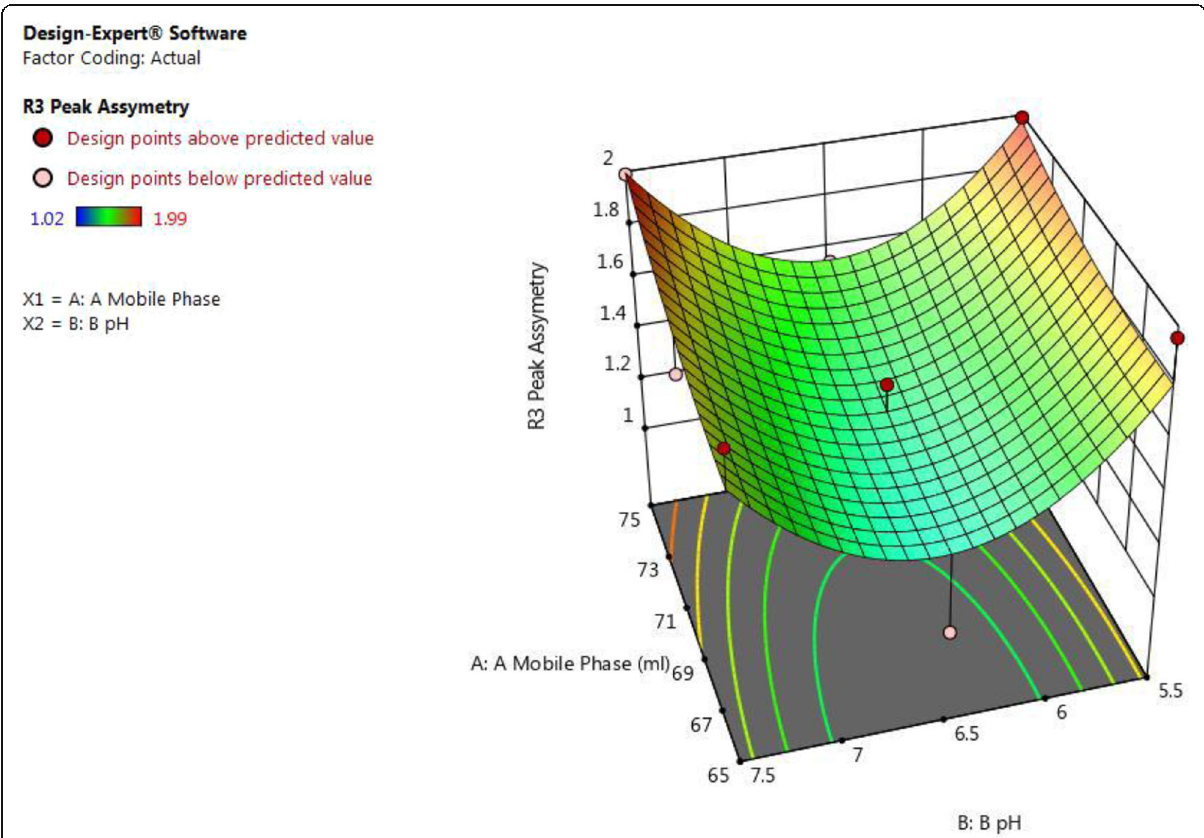
Fig. 2 3D surface plot for effect of combination of factors on R2 theoretical plate ceftriaxone sodium by using central composite design